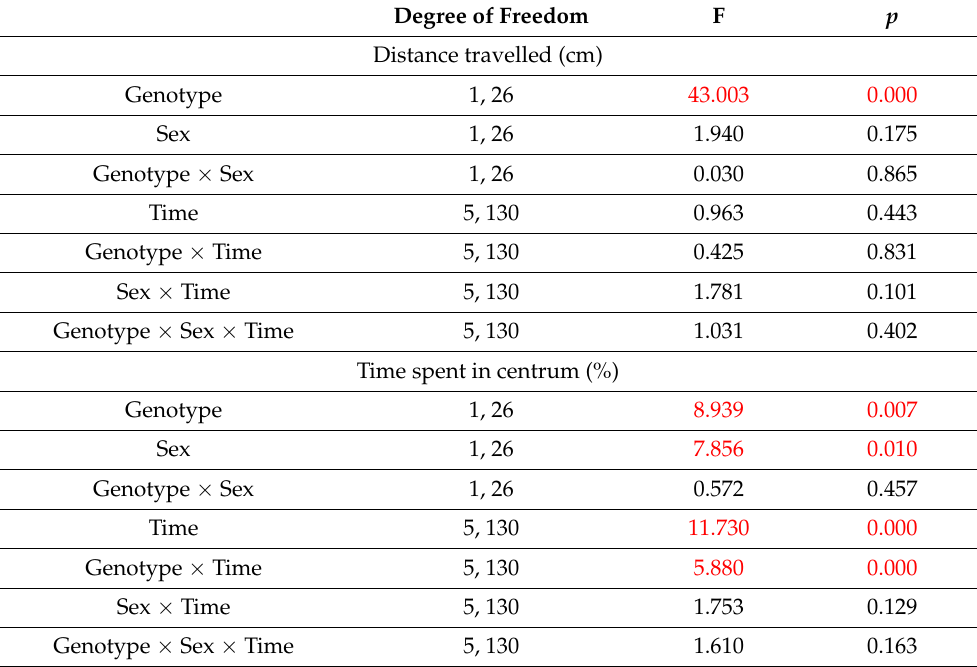
Table 5. Statistical data (results of mixed ANOVA) of open-field test (Experiment 2) in male and female, control and 3xTg-AD mice. The corresponding data are presented on Figure 5. Repeated measurements were conducted in 11-month-old animals during 30 min open-field test. Significant main effects are highlighted in red. Degree of Freedom F p Distance travelled